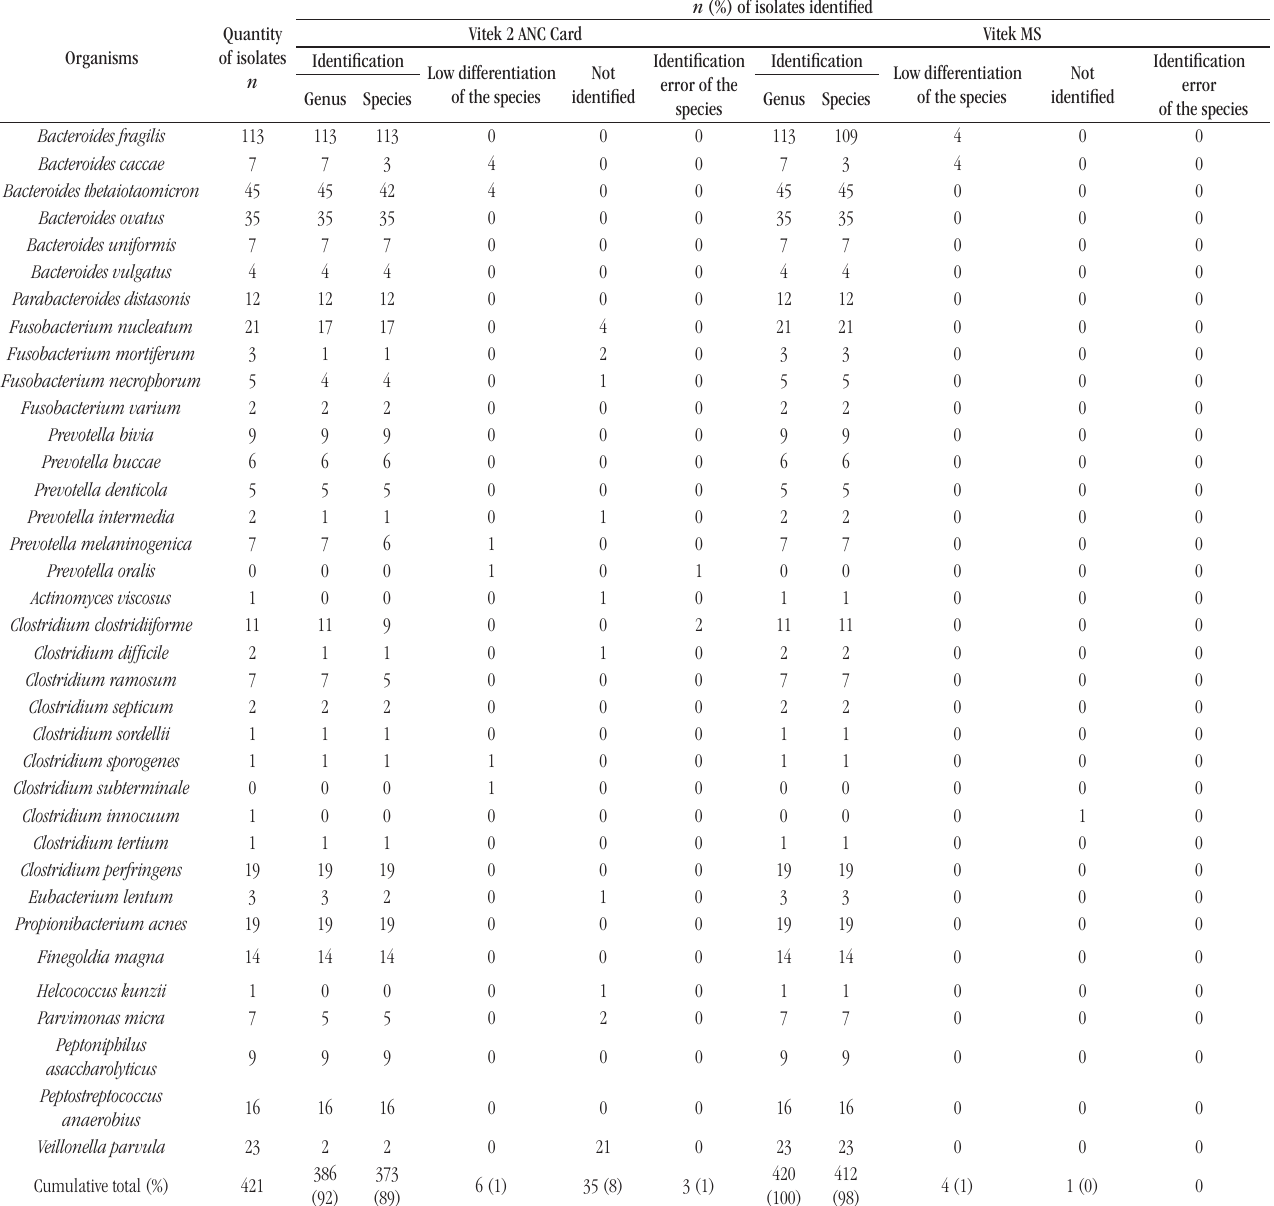
taBLE 2 − Performance of ANC (Vitek 2) and MALDI-TOF (Vitek MS) for the identification of 421 isolated anaerobes